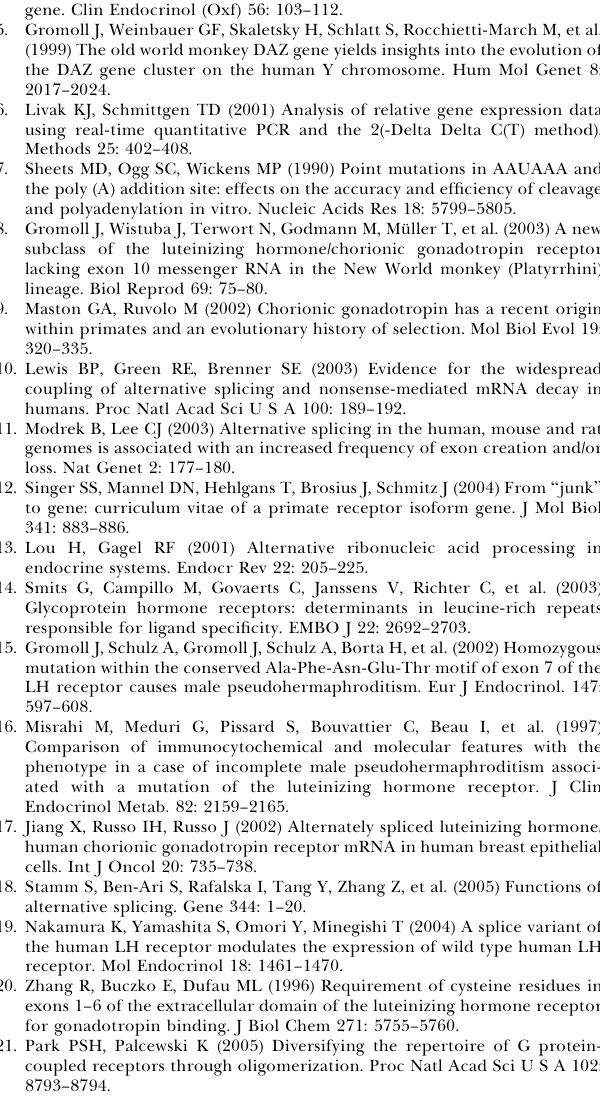
Table S1. Distribution of Exon 6A SNPs in Patients and Controls Found at doi:10.1371/journal.pmed.0050088.st001 (42 KB